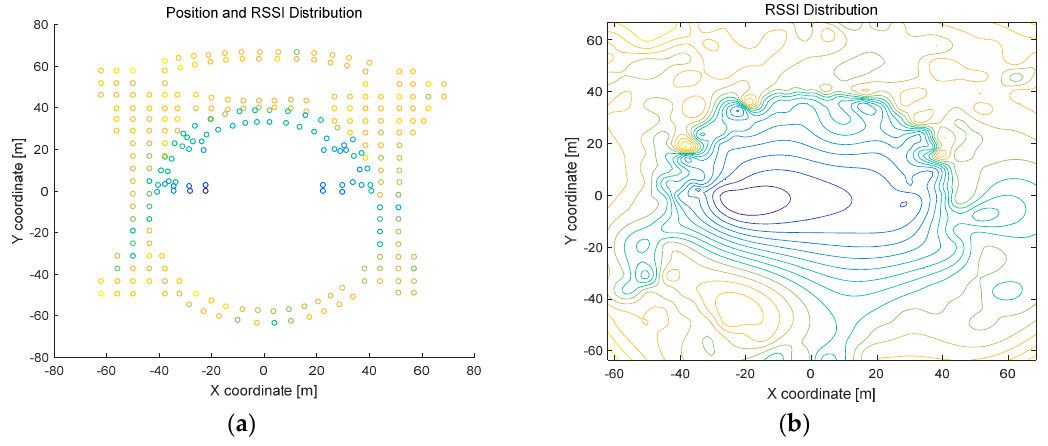
Figure 6. Reference points’ Received Signal Strength Indicator (RSSI) distribution in Test-bed 1: ( a ) RSSI distribution in scatter diagram; and ( b ) RSSI distribution in contour map.